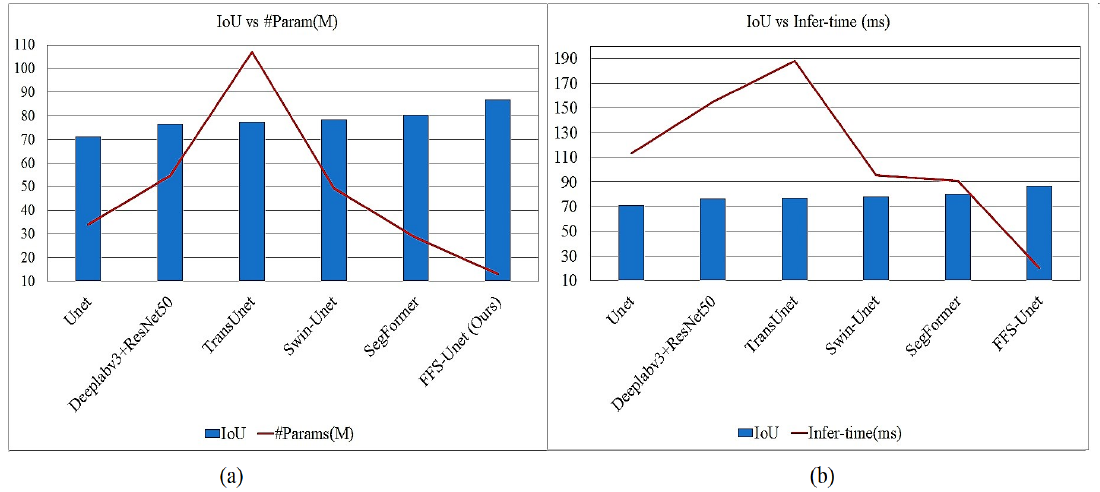
Figure 12. ( a ) Represents the relationship between the intersection-over-union (IoU) metric and the number of parameters (#Param (million (M))) of different models, and ( b ) represents the relationship between IoU and the inference time (i.e., the time duration of the model’s predictions) in milliseconds. The performance of the models varied as a function of these key